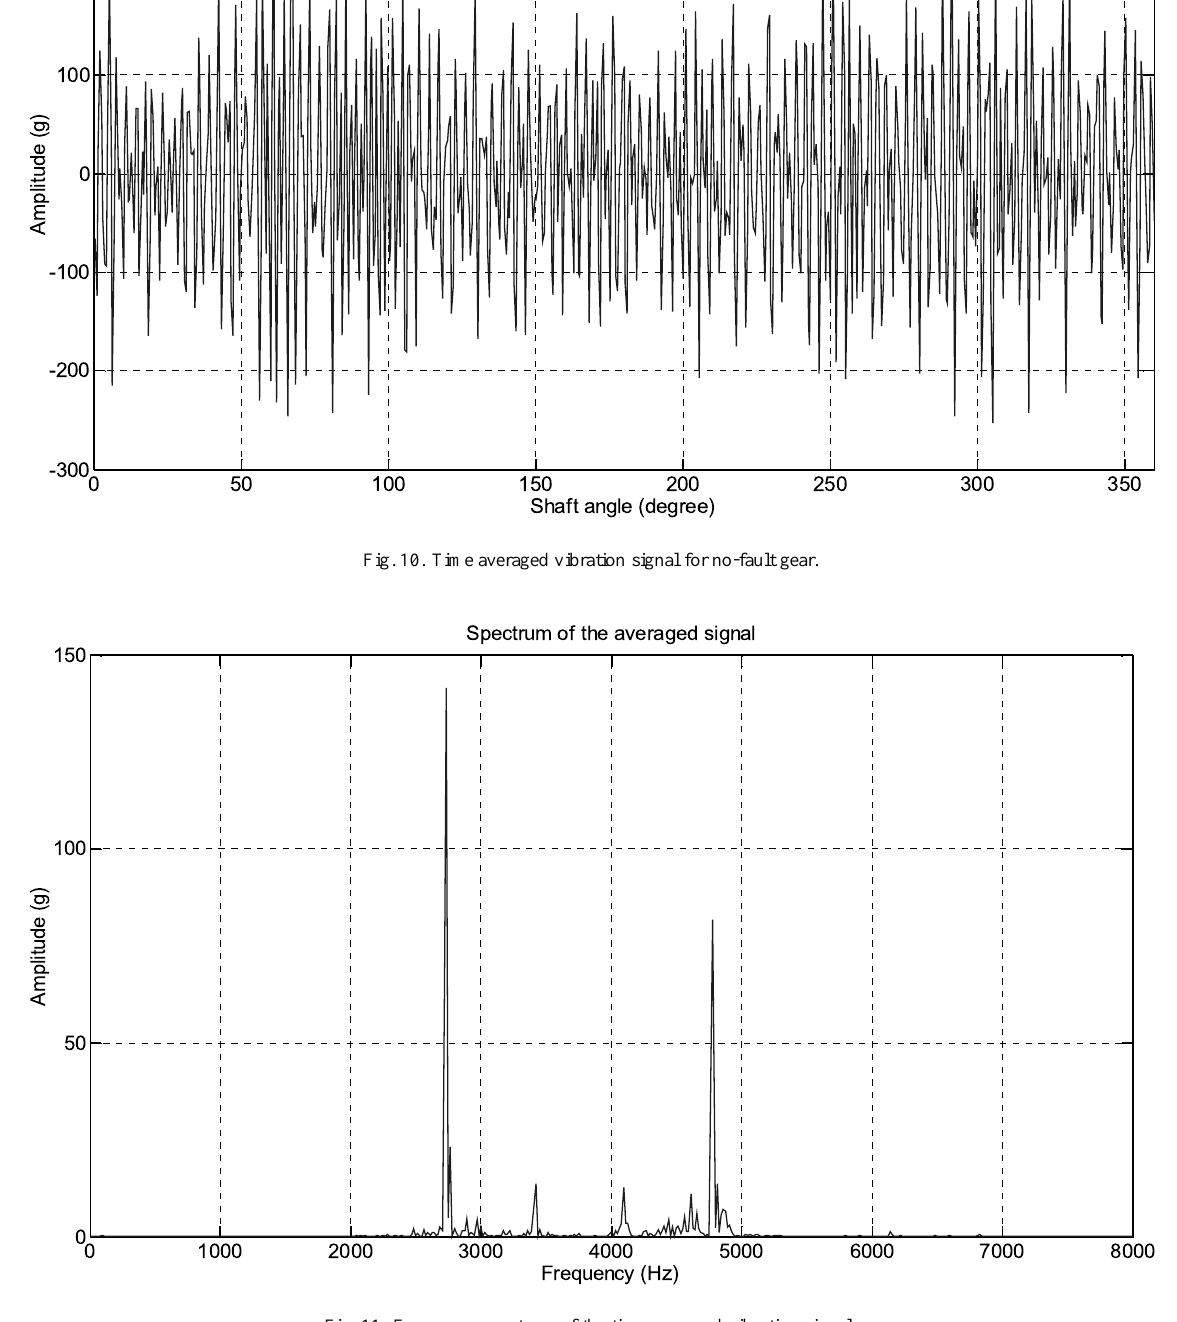
Fig. 11. Frequency spectrum of the time averaged vibration